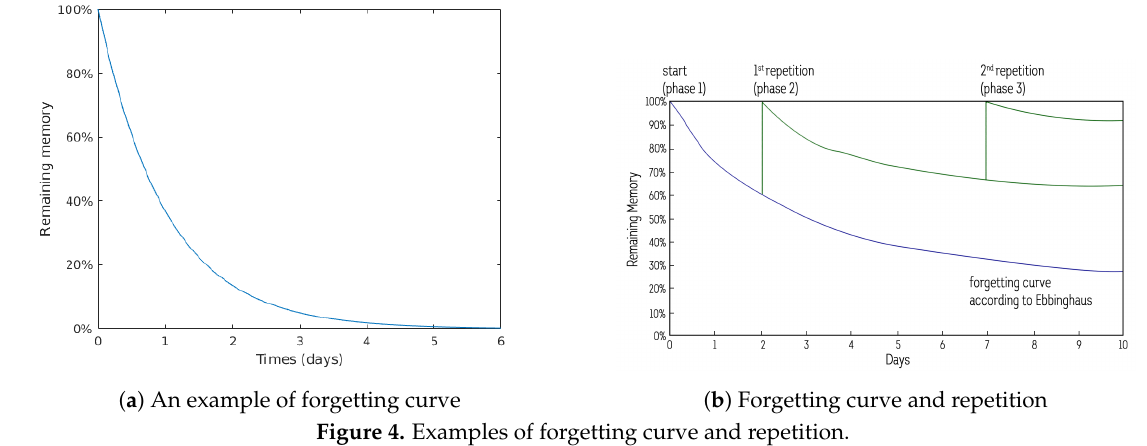
Figure 4. Examples of forgetting curve and